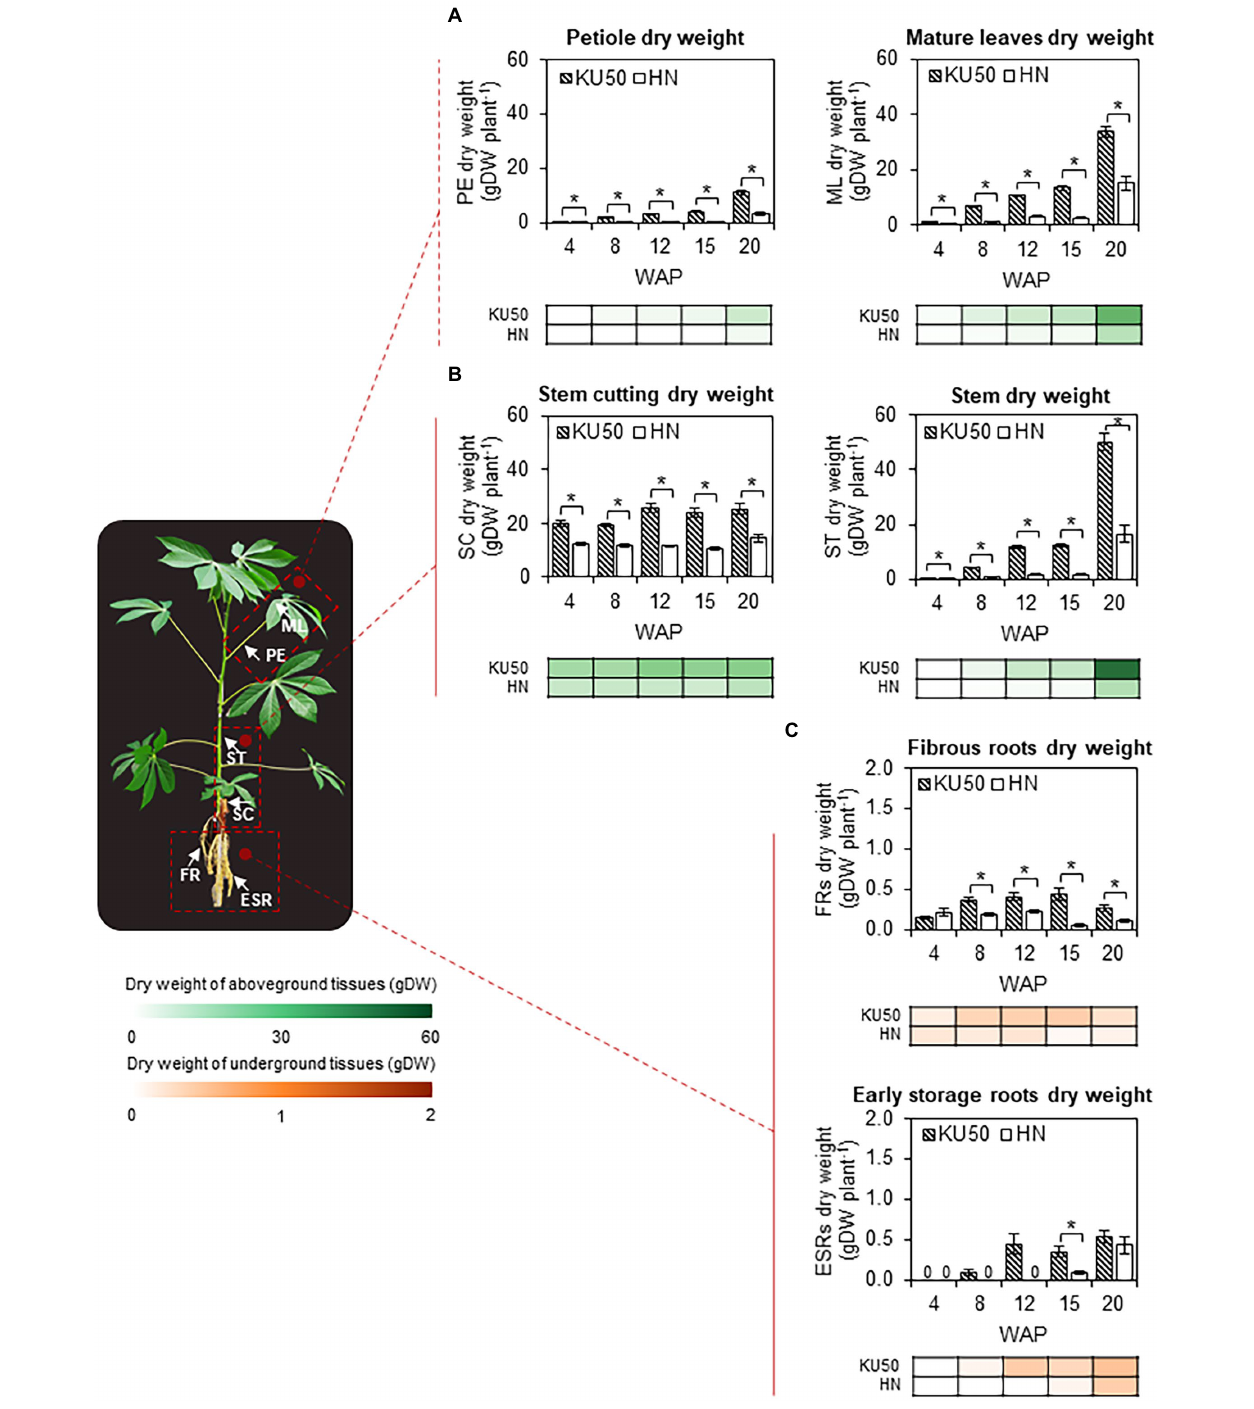
FIGURE 7 | Dry matter accumulation in (A) petioles (PE) and mature leaves (ML), (B) stem cuttings (SC) and stems (ST), and (C) fibrous adventitious roots (FRs) and ESRs of KU50 and HN cassava varieties at various developmental stages. The heat map located under each figure clearly displays the proportion of each tissue on a dry weight basis at various developmental stages. Each result, excepting the dry weight of ESRs, is the mean ± SE of values obtained from 15 biological replicates at 4, 8, and 12 WAP, and from 12 biological replicates at 15 and 20 WAP. Data on the ESRs dry weight are the mean ± SE of values obtained from three biological replicates at different stages of development. Statistical significance, based on a one-sided Student’s t -test, is denoted by * p ≤ 0.05. gDW, gram dry